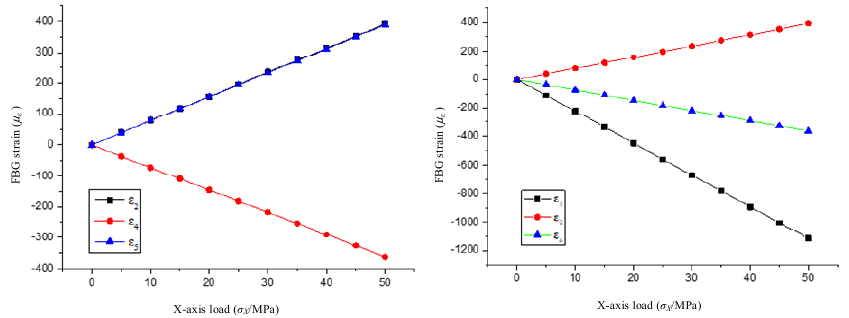
Figure 8. The variation of FBG strain with X -axis load.